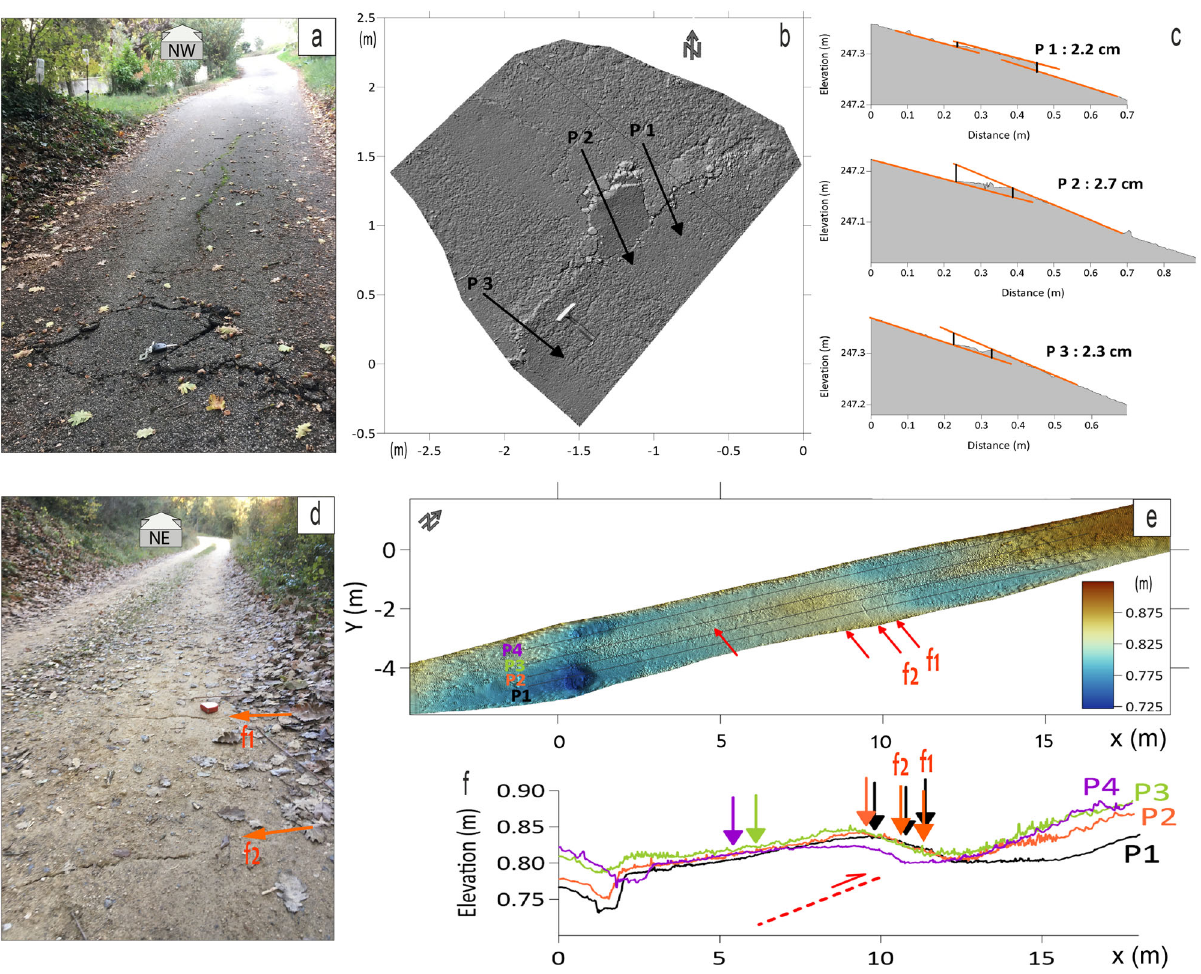
Fig. 7 Examples of surface ruptures and associated deformation measurements. a , d Field photographs showing surface ruptures affecting an asphalt road ( fl at pop-up structure) and a dirt road (extrados- fi ssures) (evidences # 7 and # 2, respectively, see location Fig. 4). b , e Ultra-high-resolution (1 mm) laser scans at the same locations. Blacks arrows in b correspond to pro fi les shown in c ; red arrows in e points to N090 – N100°E trending fi ssures (the two northeastern are those shown in d ). The thin black lines correspond to the four topographic pro fi les shown in f . Note the position of cracks on top of what we interpreted as a 5 m long bulge affecting the dirt road. c , f Topographic pro fi les extracted from laser scans, showing the vertical components (the red dotted line in f corresponds to the suspected reverse-fault rupture controlling the bulge of the dirt road).